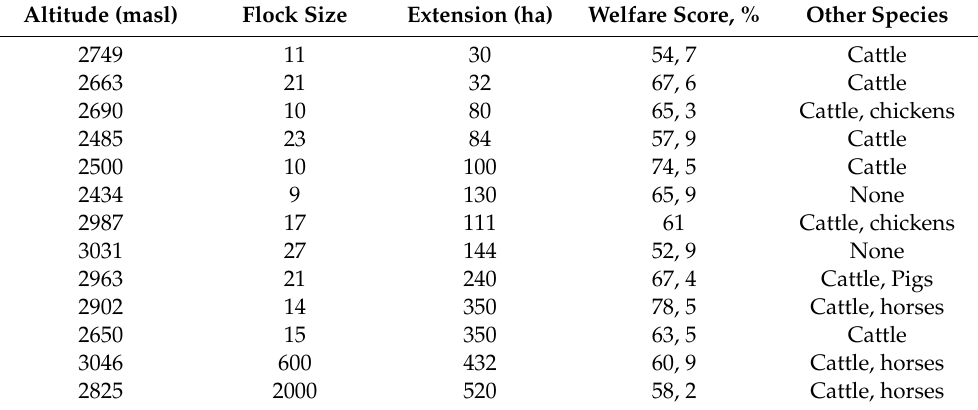
Table 2. Altitude in meters above sea level (masl), flock size (ewes > 1 year old), extension in hectares, AWIN total welfare score and other livestock species present for 13 evaluated